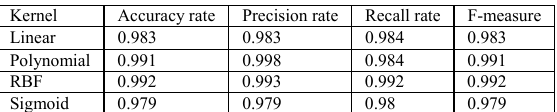
Table 6: Evaluation of each kernel function before noise reduction